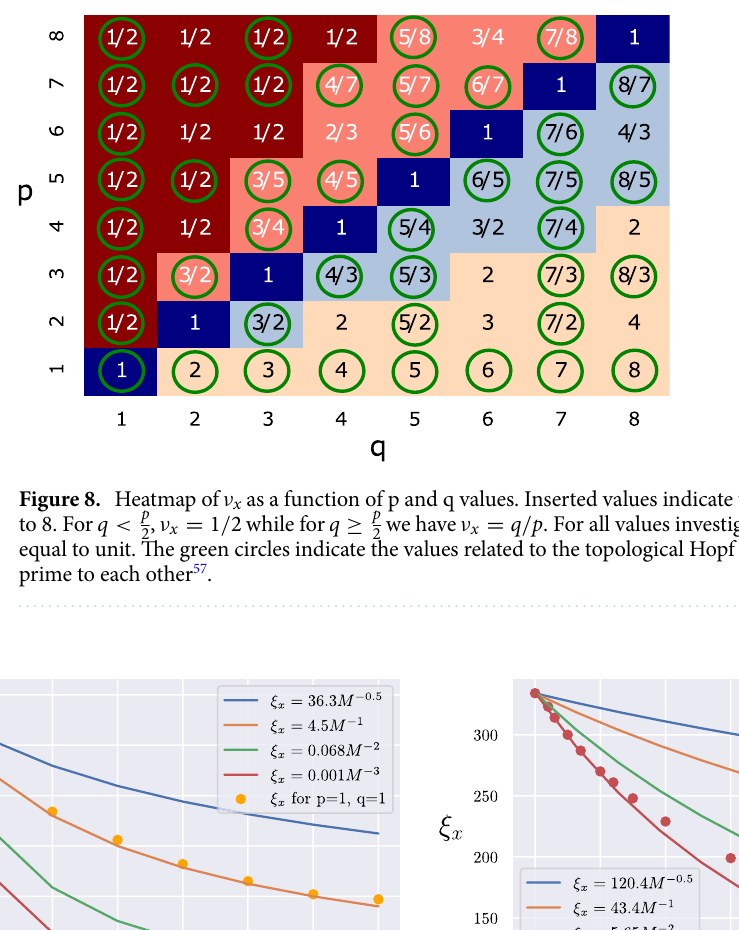
1, 1 p , q the best fit indicates ν x [ ] = [ ] 3 . These values of ν x obtained numerically confirm the =